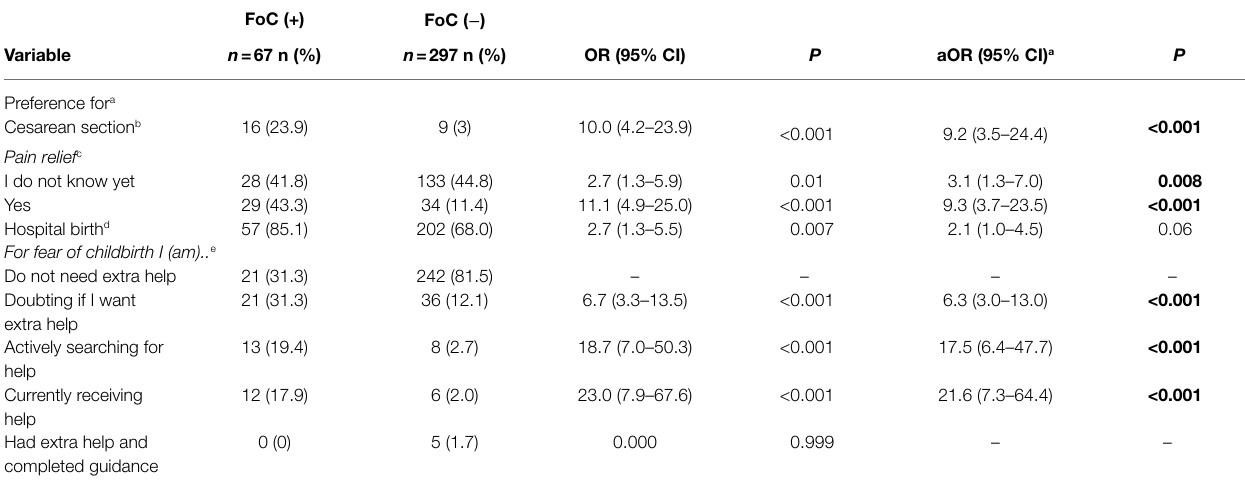
TABLE 5 | Preference for mode of delivery and self-reported need for help for